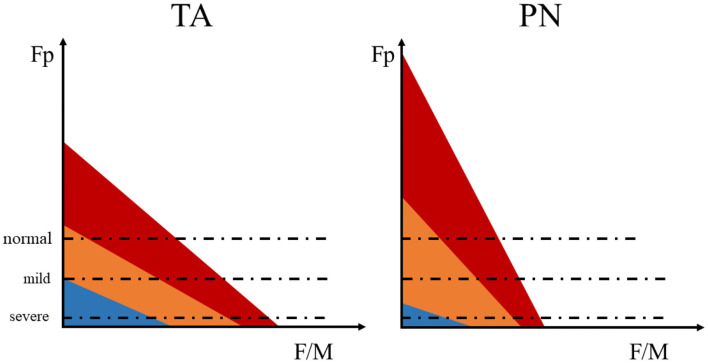
The schematic diagram of the F wave parameters influenced by changed MU excitability. The motor unit (MU) are roughly divided into three types: large MU (blue), medium MU (orange), and small MU (red). The area of each color represents the number of neurons, red > orange > blue. The dashed line represents the relative excitable threshold of the detectable F wave. Excitability exceeding the threshold indicates that the electrical stimulation is more likely to induce a detectable F wave, while excitability below the threshold infer lower probability of detectable F wave under stimulation.